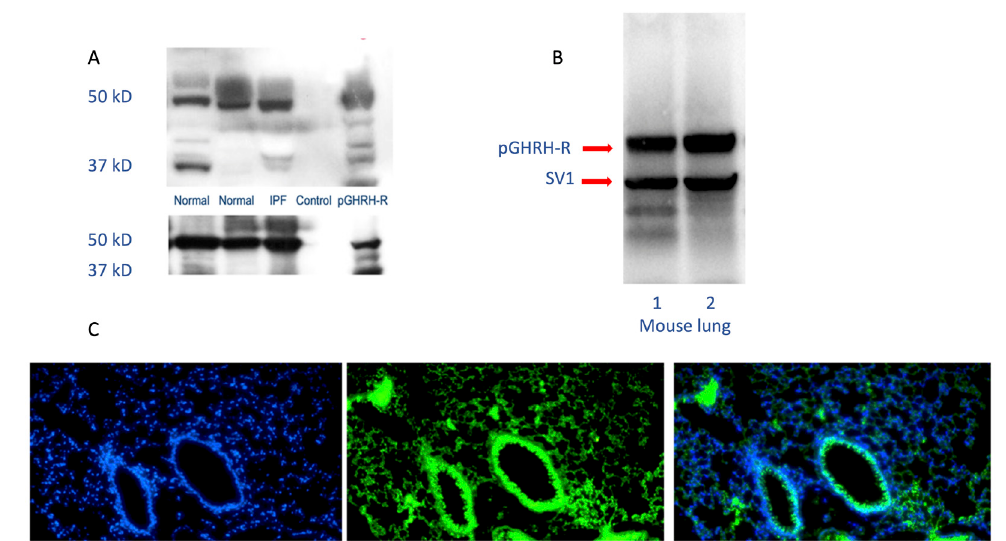
Figure 1. Human and mouse lung westerns (upper panels A and B ) and immunofluorescence staining (lower panel C ) demonstrate growth hormone-releasing hormone-receptor (GHRH-R) protein. As shown in the upper panels, Western blotting confirms the presence of pituitary-type GHRH-R (pGHRH-R) and splice variant (SV1) in both normal and IPF human lung tissues (upper left panel). Likewise, the pGHRH-R is abundant in lung tissue protein from normal C57BL / 6J mice (upper right panel).